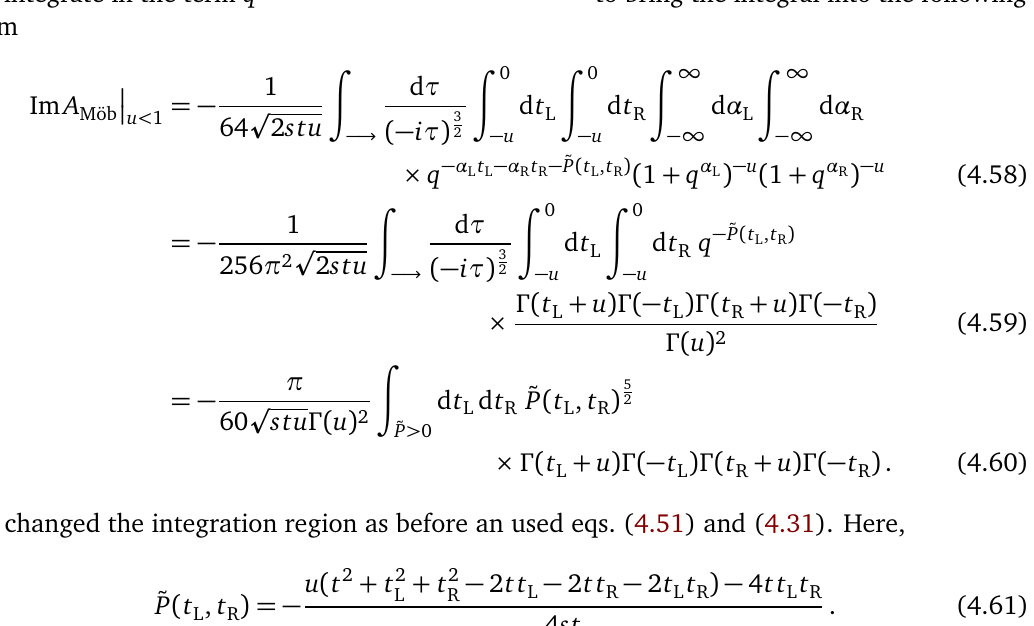
Figure 17: Left: the region in the ( z picture is drawn for s = − 1 cut in the u